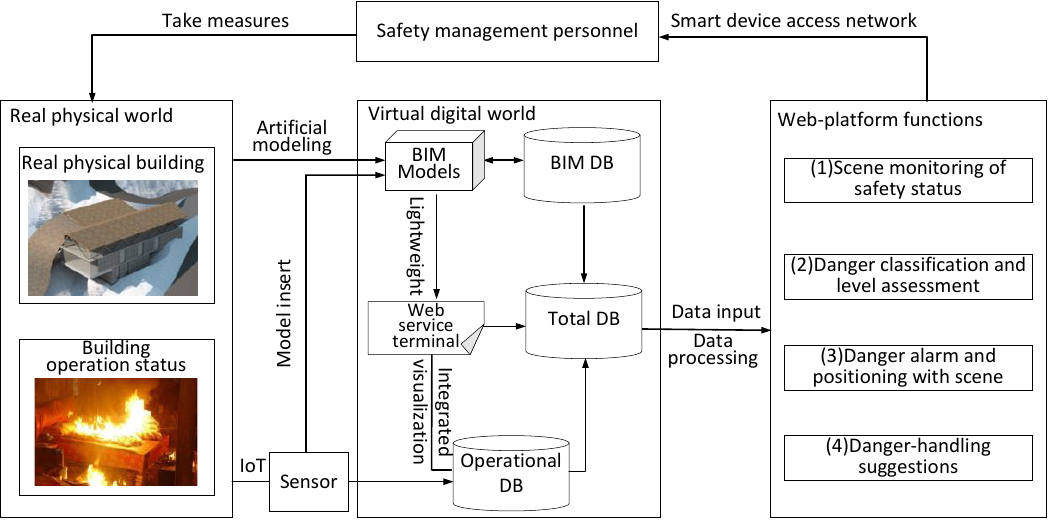
Figure 2. Framework of the proposed ISMS based on the digital twin method.